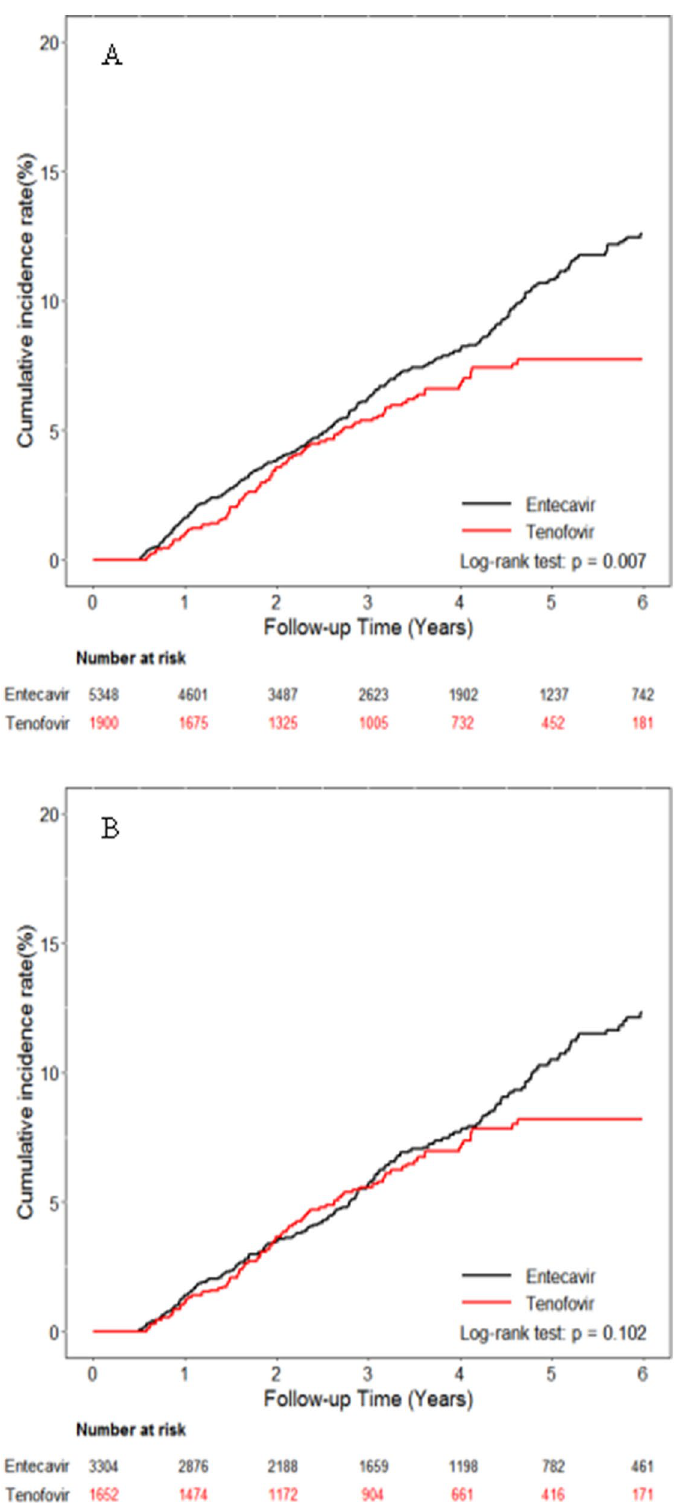
Figure 1. Cumulative incidences of HCC. ( A ) Entire cohort ( B ) Propensity score matching